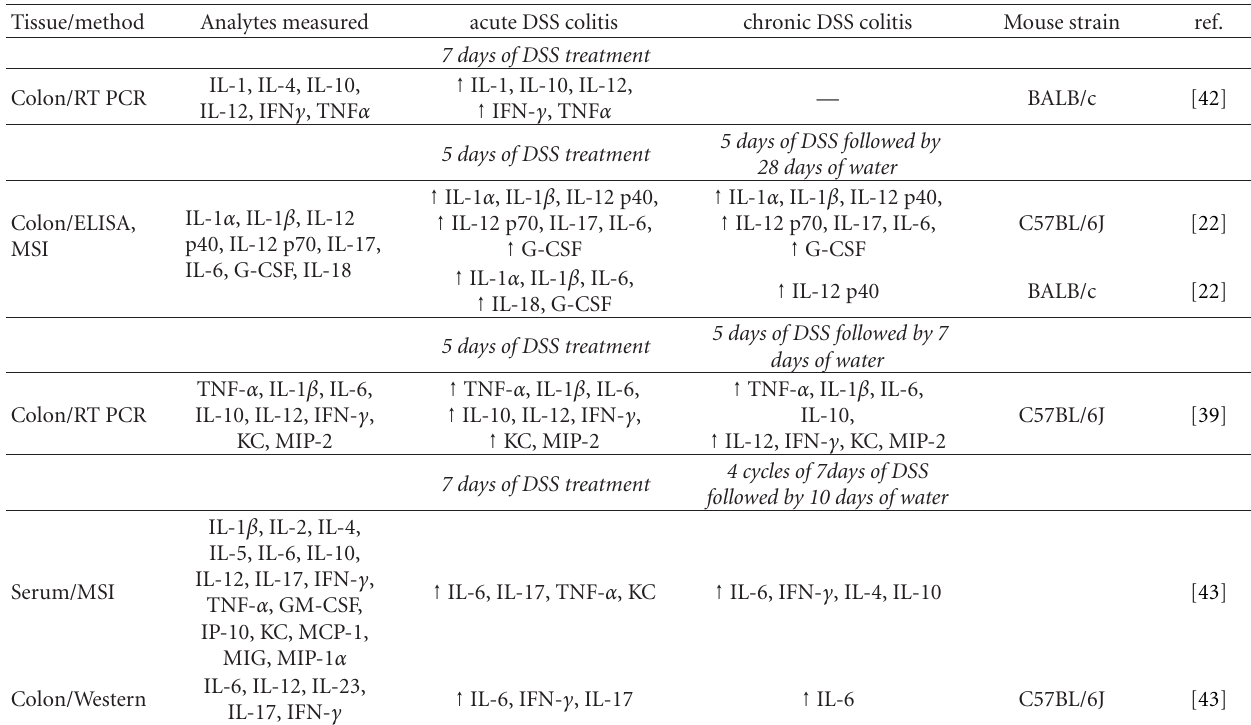
Table 3: Profile of inflammatory mediators in di ff erent phases of DSS-induced colitis in